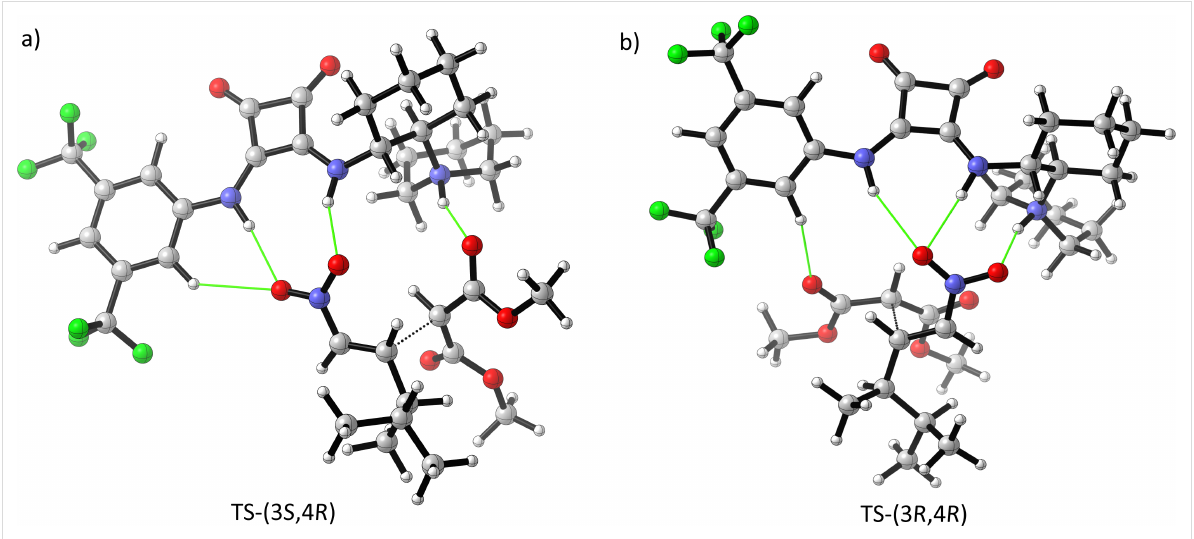
Figure 2: Transition state models for the reaction of ( R )- 6 with dimethyl malonate using catalyst C7 (M06-2X/6-311+G**-C-PCM(toluene)//HF/6- 31G*).